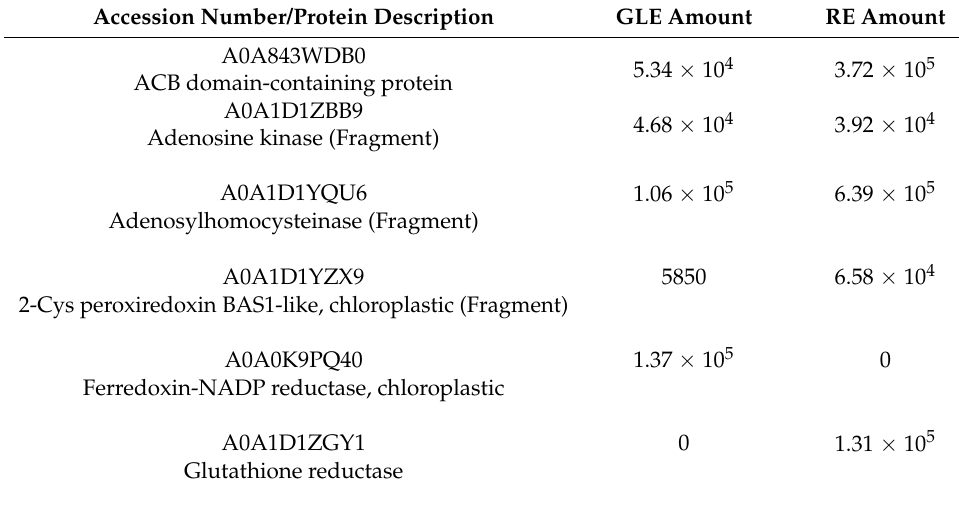
Table 3. Cytotoxic activity-associated proteins identified in GLE and